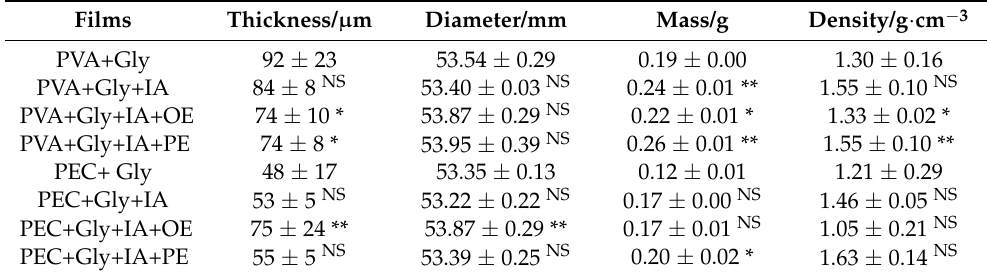
Table 4. Thickness, diameter, mass, and density of films.